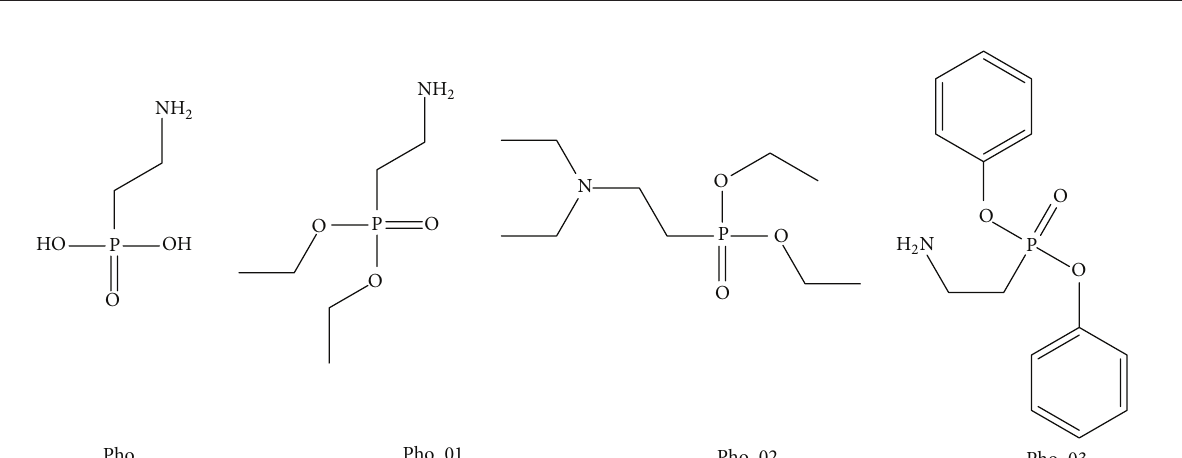
Figure 2: Structure of phosphoethanolamine (Pho) and three analogues (Pho 01 to Pho 03), substituting hydroxyl group on phosphate and amine group in Pho